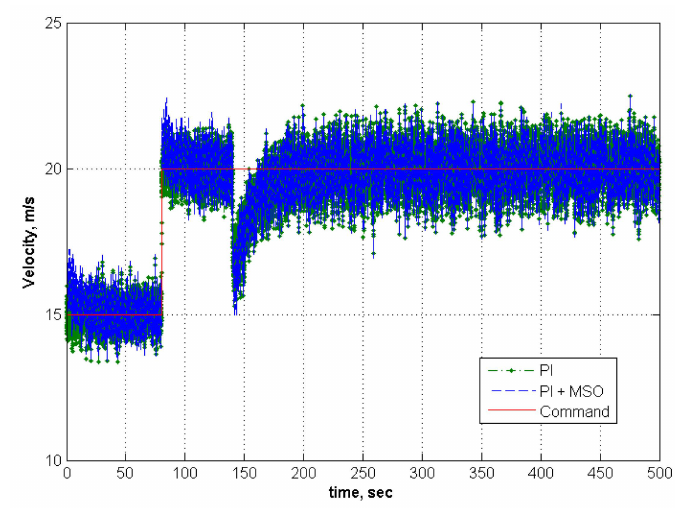
Figure 23. Velocity response for 50% C m α in the controller.